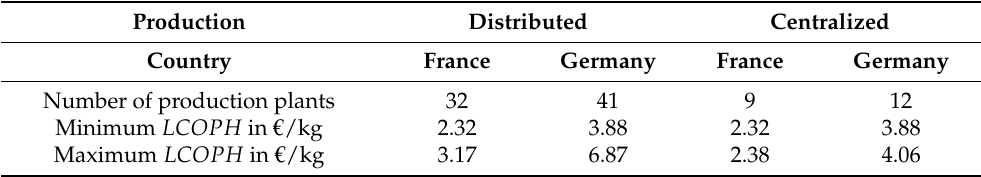
Table 3. Maximum production plant (HPP) size for different non-household consumers